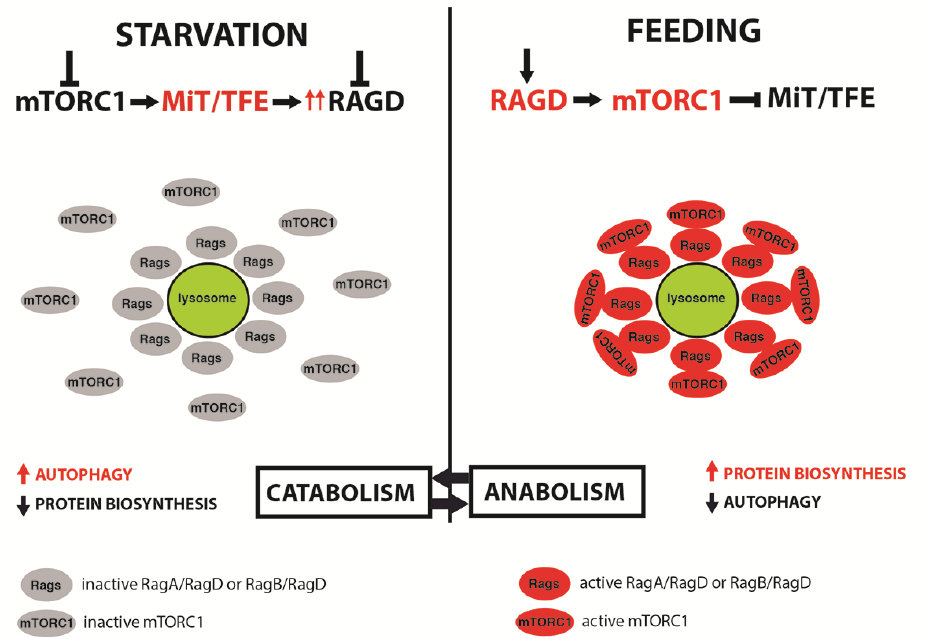
FIGURE 1: Proposed model of MiT/TFE–mediated trans- criptional